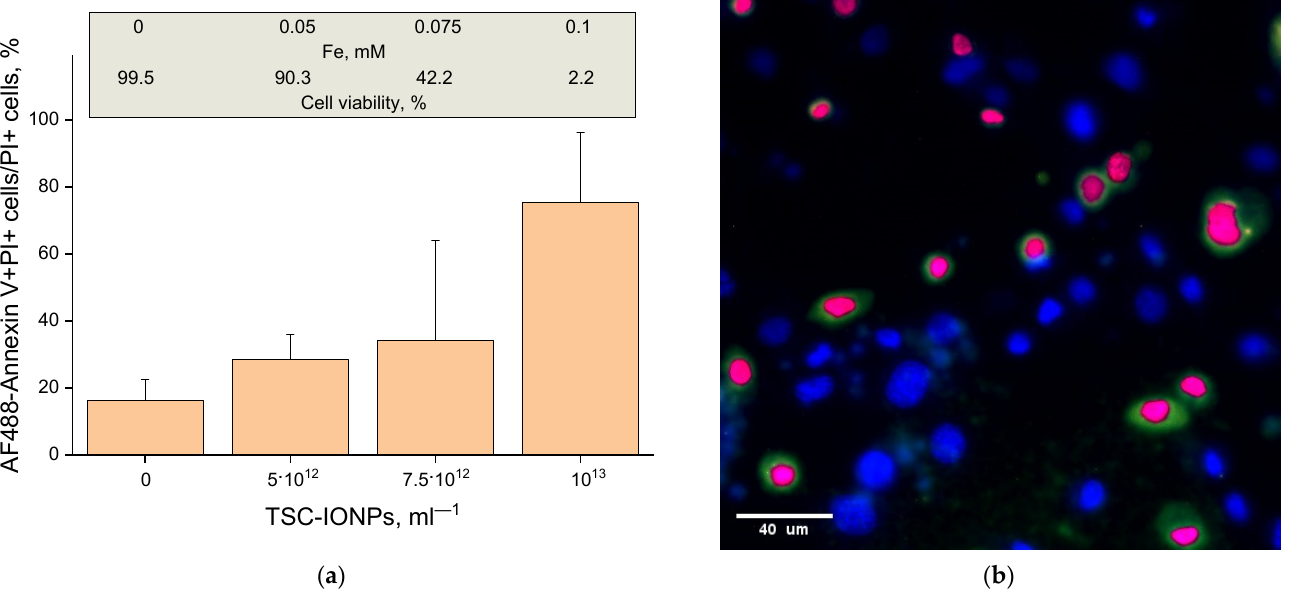
Figure 10. The ratio of apoptotic cells (colored green with AF488-Annexin V+PI+) to the total number of dead cells (colored purple PI+) ( a ), a sample photo of the concentration of TSC-IONPs 7.5 × 10 12 mL − 1 ( b ).